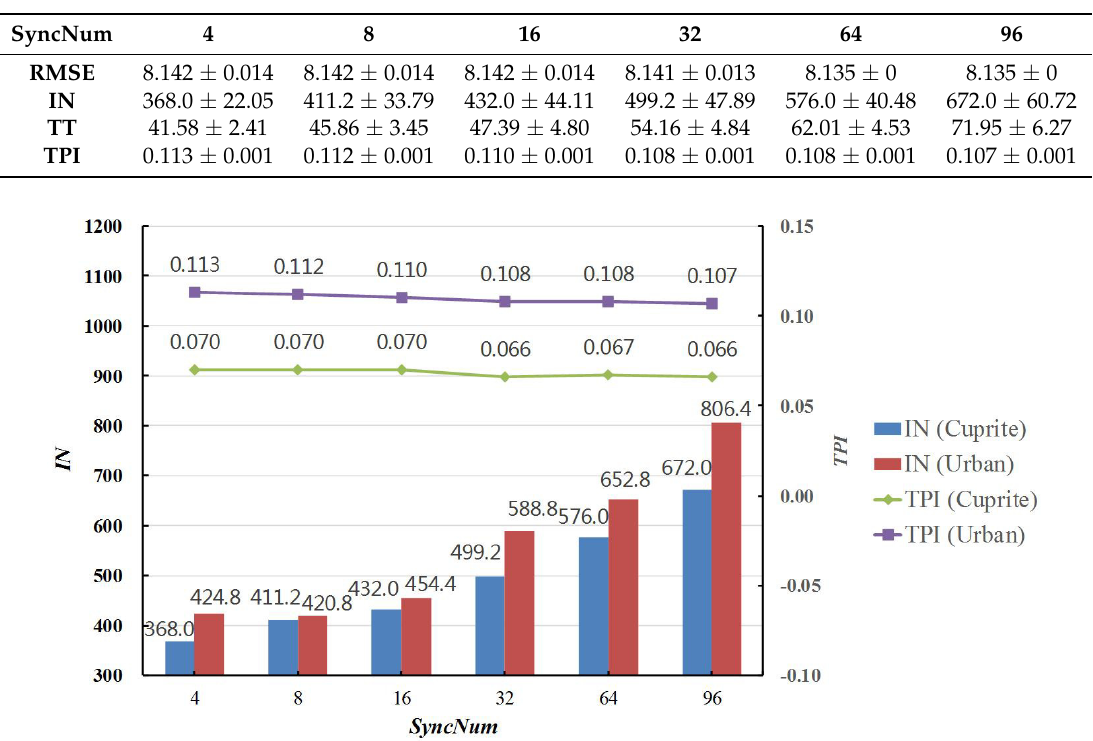
Figure 7. Time Ratios of MG-ACOEE with different SyncNum and